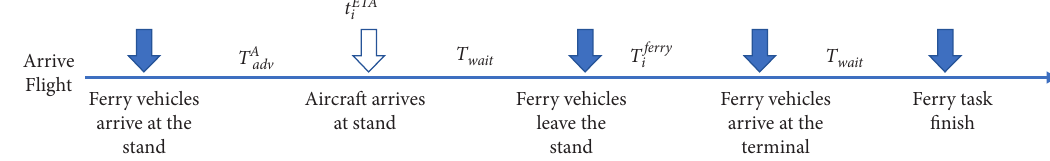
Figure 5: A complete structure diagram of airport ferry network.